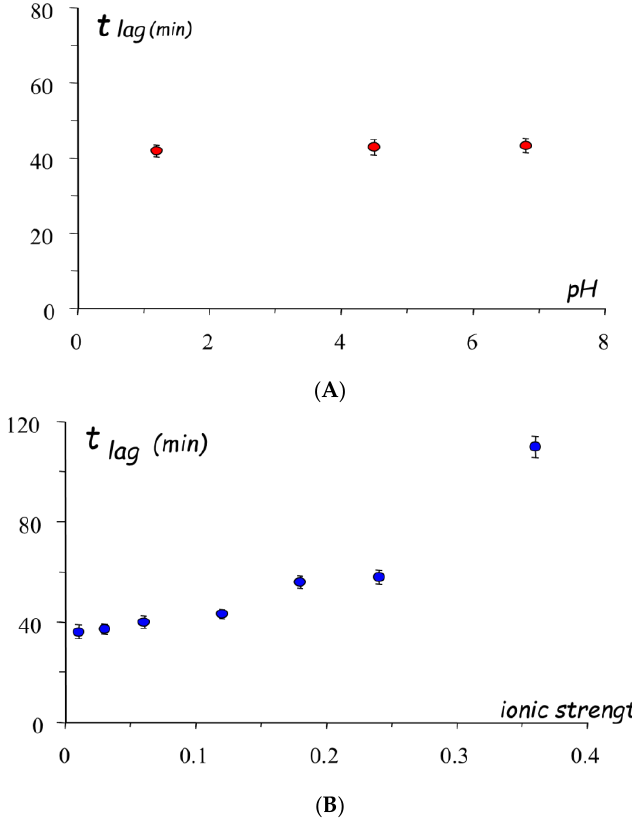
Figure 21. Mean salivary antipyrine concentration profiles after oral administration of uncoated cores (A) and systems coated with Methocel ® E50 up to 50% (B) and 100% (C) weight gains. Adapted with permission from Ref. [61]. 2001, Elsevier.